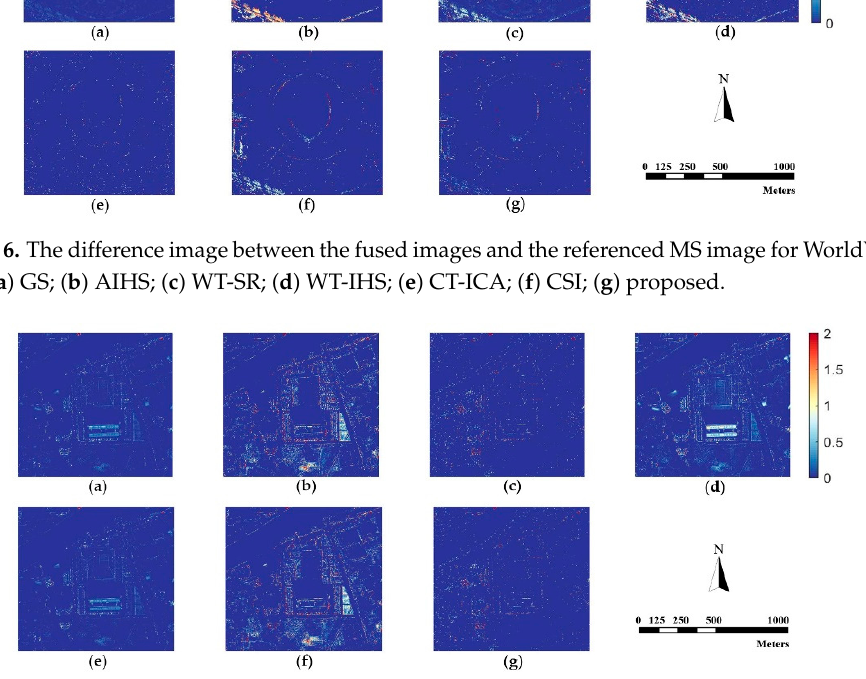
Figure 7. The difference image between the fused images and the referenced MS image for Pleiades data. ( a ) GS; ( b ) AIHS; ( c ) WT-SR; ( d ) WT-IHS; ( e ) CT-ICA; ( f ) CSI; ( g ) proposed.